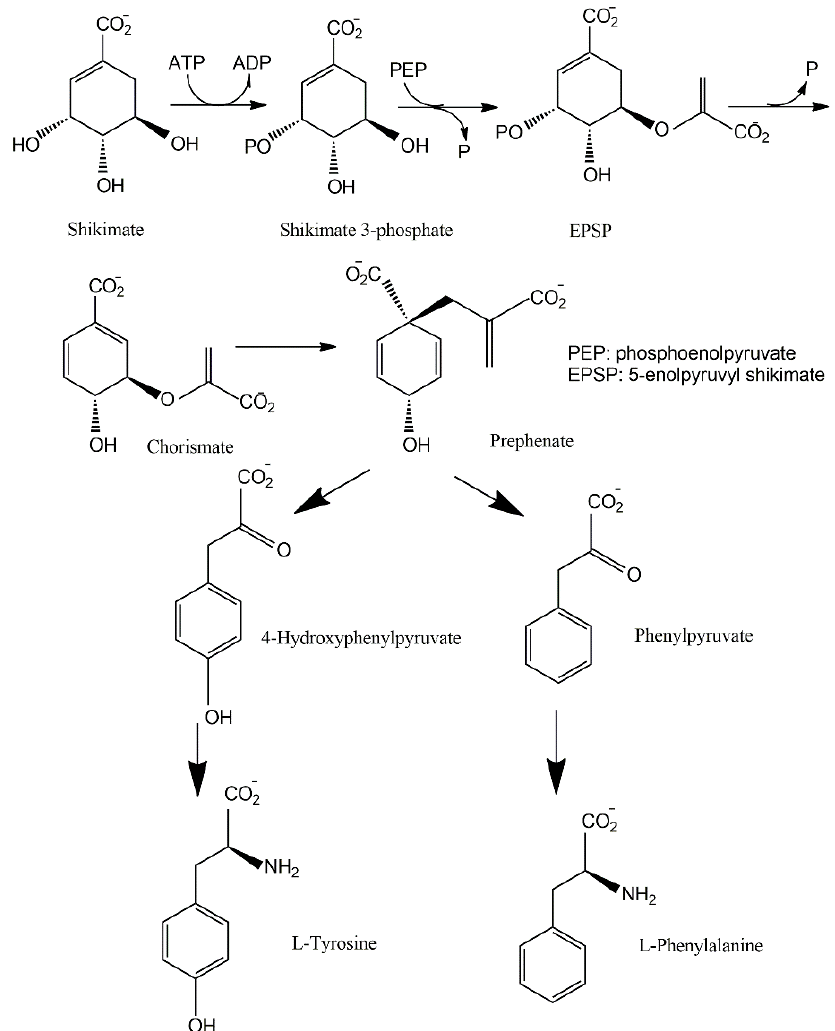
Figure 7. Shikimate pathway leading to biosynthesis of p -terphenyls.